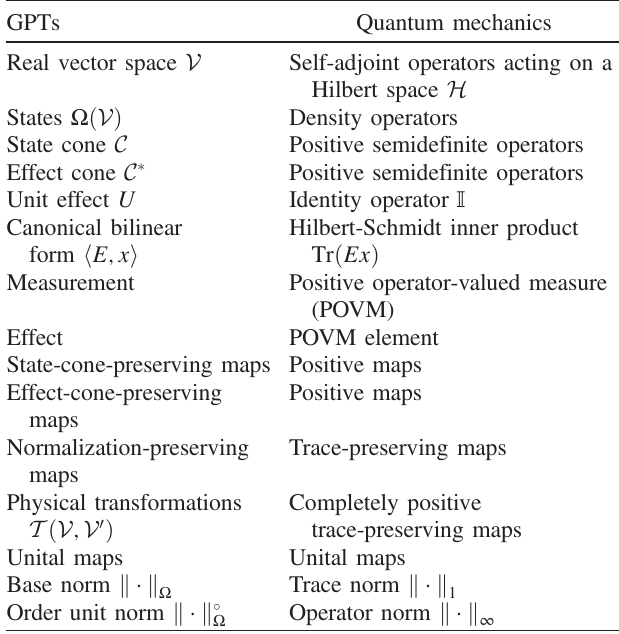
TABLE I. A comparison between the concepts and standard nomenclature used in finite-dimensional quantum mechanics and in more general